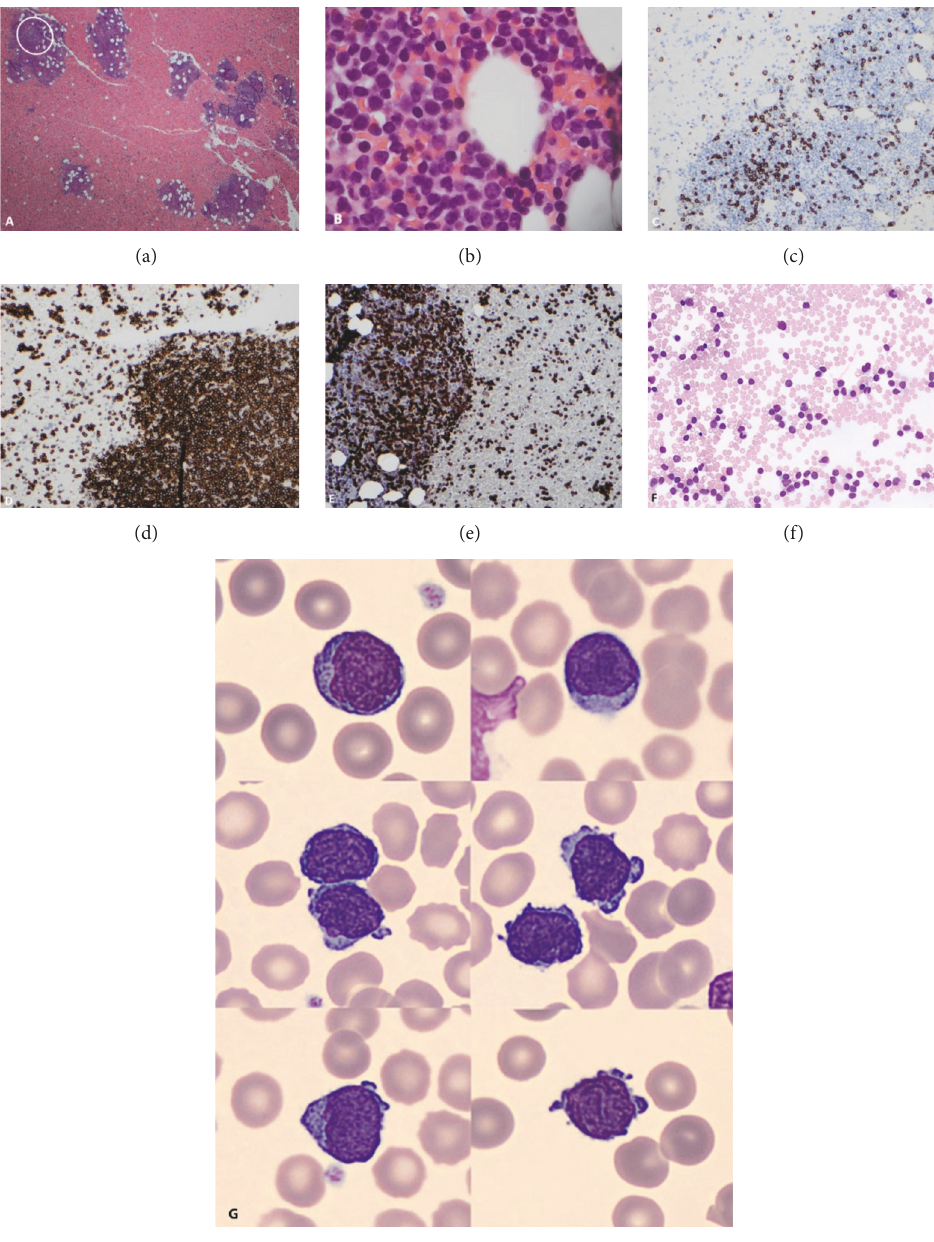
Figure 4: T-PLL in bone marrow biopsy specimen. A bone marrow clot section shows multiple lymphoid aggregates (white circle)composed predominantly of small-to-intermediate-size lymphocytes ((a), low power, (b), high power). The B-cell marker CD20 highlights scattered small lymphocytes (c). The T-cell marker CD3 highlights most lymphocytes in the lymphoid aggregates (d, e). Bone marrow aspirate smear shows numerous small-to-intermediate-size lymphocytes with scant cytoplasm displaying small projections and central nuclei with distinct nucleoli (f). The spectrum of T-PLL lymphocytes in the peripheral blood is shown (g); lymphocytes are predominantly small to intermediate in size with oval to slightly irregular nuclei and distinct nucleoli. The cell contours show blebs, while the cytoplasm is bluish and eccentric. Similar peripheral blood features were noted at initial presentation 3 years